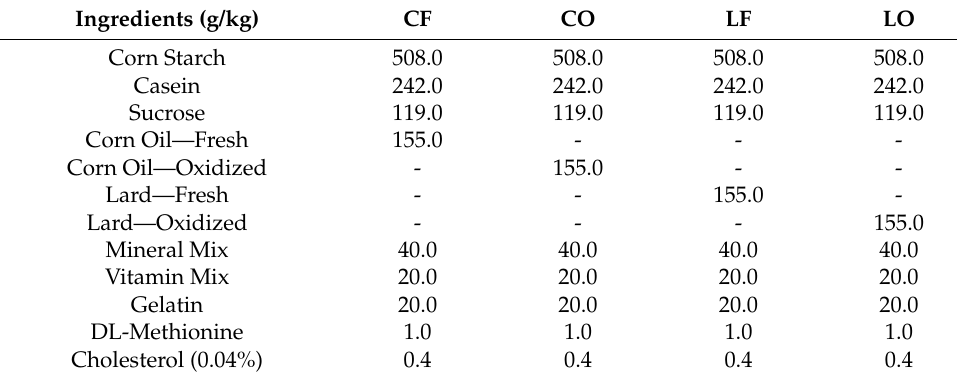
Table 1. Composition of the four diets: CF, fresh corn oil; CO, oxidized corn oil; LF, fresh lard; LO, oxidized